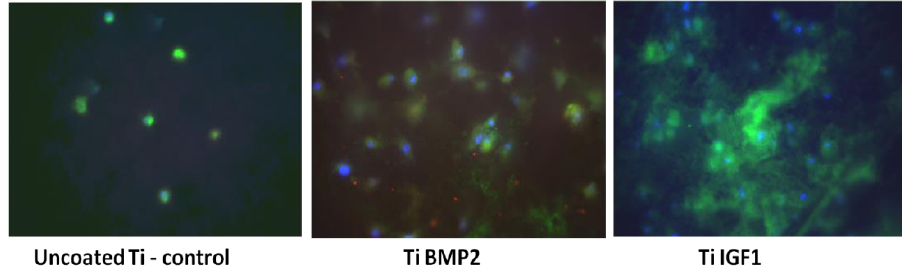
Figure 12. Immunocytochemical staining of BM MSC cells cultivated onto titanium implants for 7 days, with FITC (green) for osteopontin and phalloidin TRITC (red) for actin F. The actin F fibers could not be viewed in these captured images.